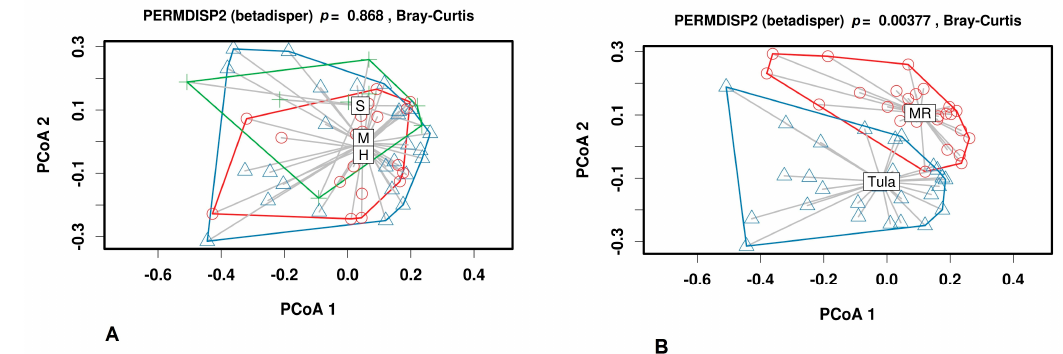
Figure 4. PERMDISP2 beta diversity analysis of microbiota. ( A ) H (red circles), M (blue triangles), and S (green crosses) samples. ( B ) Tula (blue triangles) and Moscow (red circles) Regions.